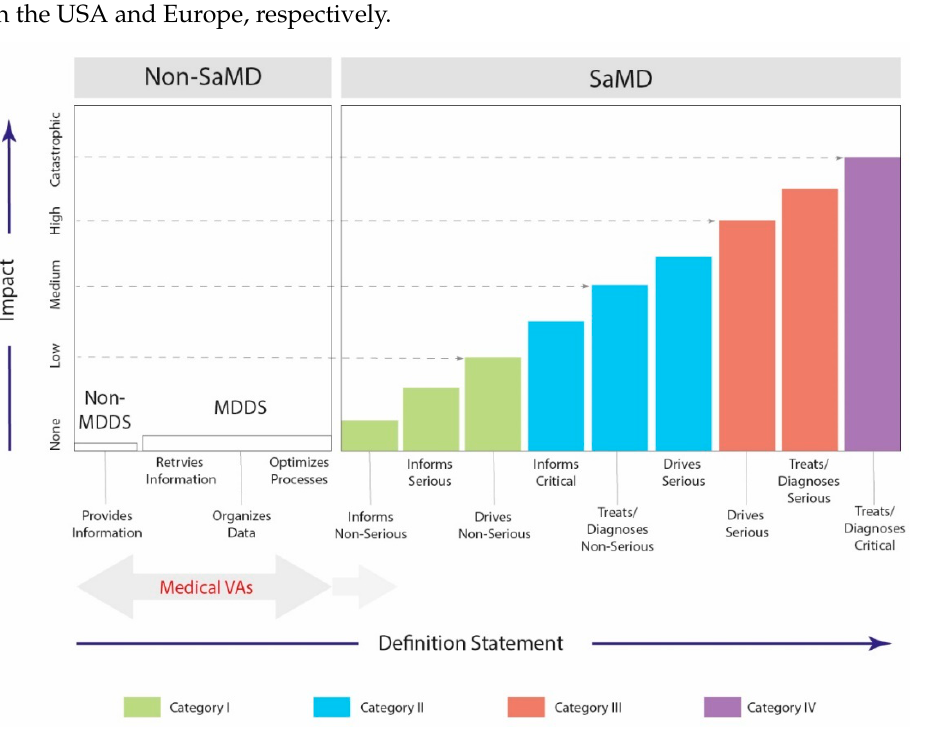
Figure 1. Risk-based approach to evaluate and categorize software designed for medical purposes. Category I-IV reflects an impact on patients being associated with medical utilization (inform, drive, treat, diagnose) and clinical scenarios that the service is intended for (non-serious, serious, critical). Non-MDDS—Non-Medical Device Data Systems; MDDS—Medical Device Data Systems; SaMD— Software as a Medical